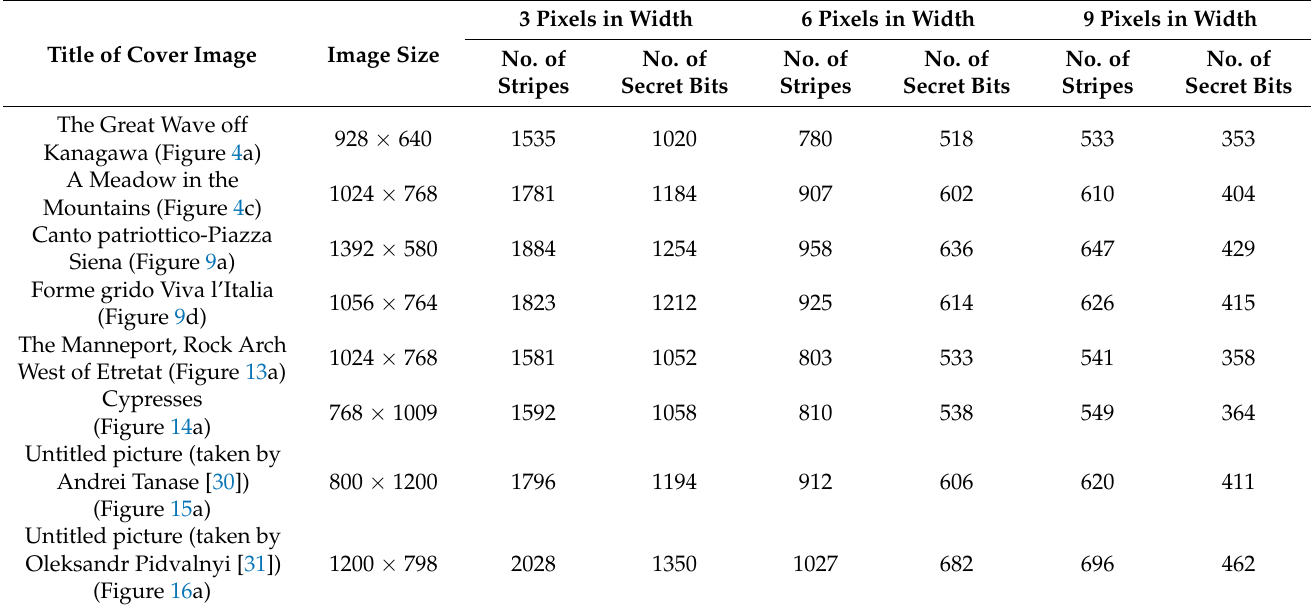
Table 3. Embedding capacities (in the unit of bit) of eight cover images with different stripe